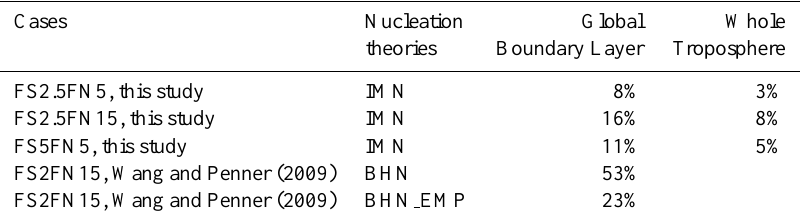
Table 3. A comparison of simulated impacts of different assumptions of primary sulfate emission on global annual mean CCN0.2. The percentage given in the table is the change relative to the case without any primary sulfate emission (i.e., FS =